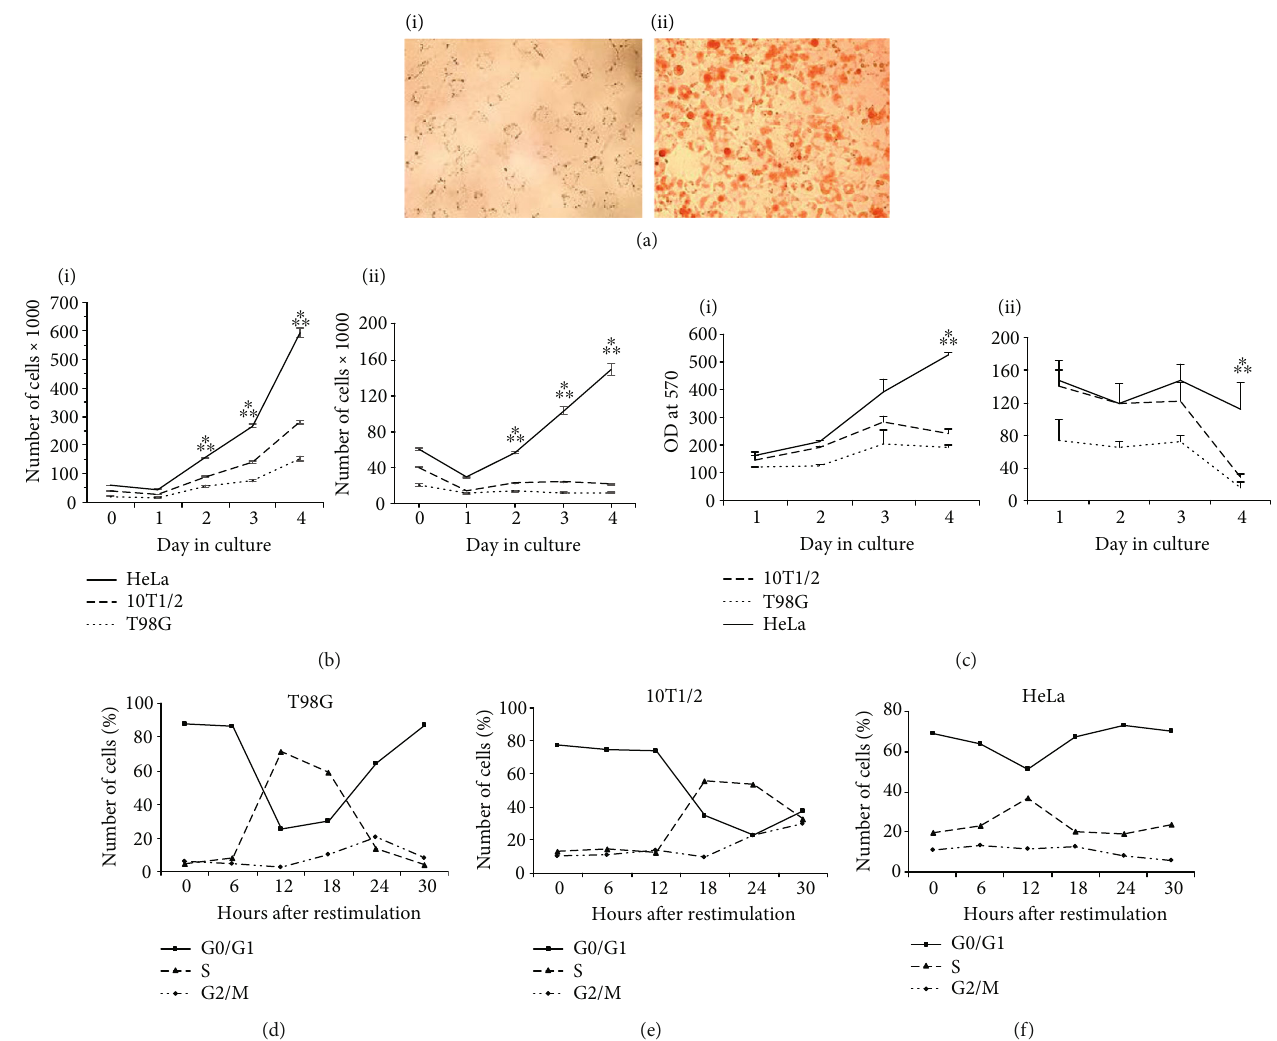
Figure 1: MSCs of the 10T1/2 cell line show serum-dependent growth restriction and cell cycle-dependent oscillation. (a) 10T1/2 cell line possesses the ability to adipocyte di ff erentiation. The cells were observed before AD ( i ) and in 10 days (ii ) after the induction of AD and Red Oil staining under the Pascal microscope (Carl Zeiss, Germany) with transmitted light using a 10x objective. (b) Growth curves of T98G, 10T1/2, and HeLa cell lines: i — full growth medium, ii — serum-deprived medium. Equal cell numbers of each line were plated into wells of 96 cell culture plate in triplicate and counted every day until day 4. The data are presented as mean ± SD , ∗ — p < 0 : 01 compared to the 10T1/2 cells, ∗∗ — p < 0 : 01 compared to the T98G cells. (c) Cell proliferation rate of the 10T1/2 cells: i — full growth medium, ii — serum-deprived medium. The cell proliferation rate was estimated using the MTT assay. The asynchronously growing 10T1/2, T98G, and HeLa cells were seeded at a concentration of 2 × 10 4 cells/well in 100 μ l full culture medium in 24 wells of 96-well cell culture plate and incubated for 24 h. Then, 12 wells containing cells of each cell line were fi lled with full growth medium (FM) while the other 12 — with serum-free medium (SFM). For the next four days, the cells were treated with the MTT reagent followed by measuring OD by ELISA reader at 570nm. The data are presented as mean ± SD , ∗ — p < 0 : 05 compared to the 10T1/2 cells, ∗∗ — p < 0 : 05 compared to the T98G cells. (d – f) Flow cytometry analysis of cell cycle progression of T98G, MSCs, and HeLa cell lines, accordingly. The cells were cultured for 72h in DMEM with 0.15% FCS, restimulated with 10% FCS, and used for fl ow cytometry in 6 h intervals after